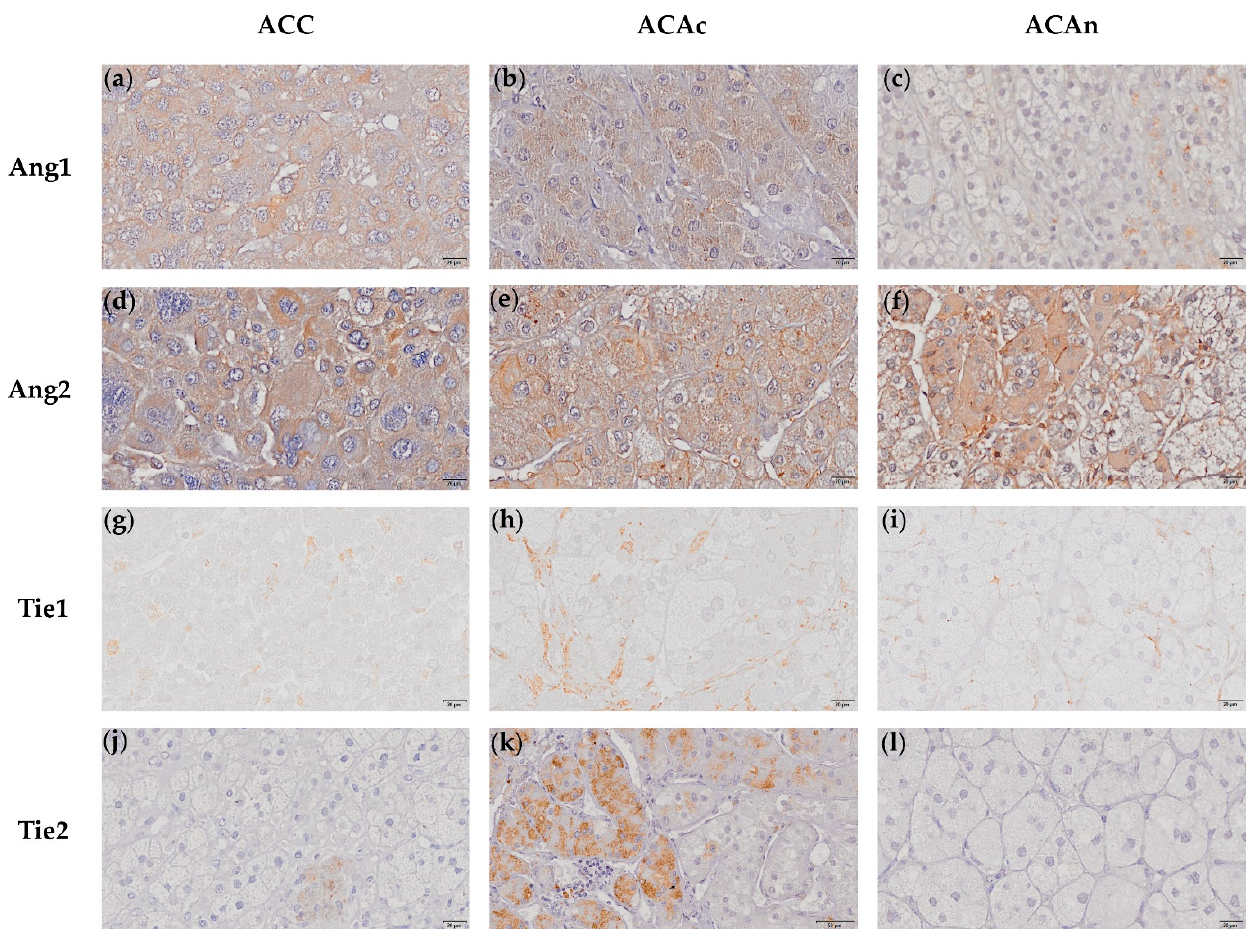
Figure 4. Immunochemistry staining of adrenocortical carcinoma (ACC), adrenocortical adenoma with Cushing syndrome (ACAc) and non-functioning adrenocortical adenoma (ACAn) for Ang1 (20 µm) ( a – c ), Ang2 (20 µm) ( d – f ), Tie1 (20 µm) ( g – i ) and Tie2 (20 µm) ( j – l ). Cytoplasm staining for Ang1 in ACC, ACAc and ACAn ( a – c ); Ang2 cytoplasm staining ( d – f ); Tie1 cytoplasm staining ( g – i ); Tie2 cytoplasm staining in ACC and ACAC ( j – k ); and negative staining of Tie2 in ACAn cells ( l ).